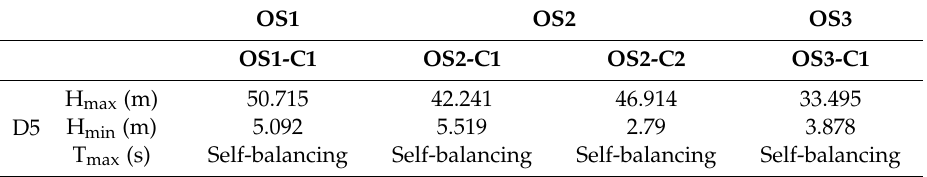
Table 6. The transient processes in three operating scenarios under D5.